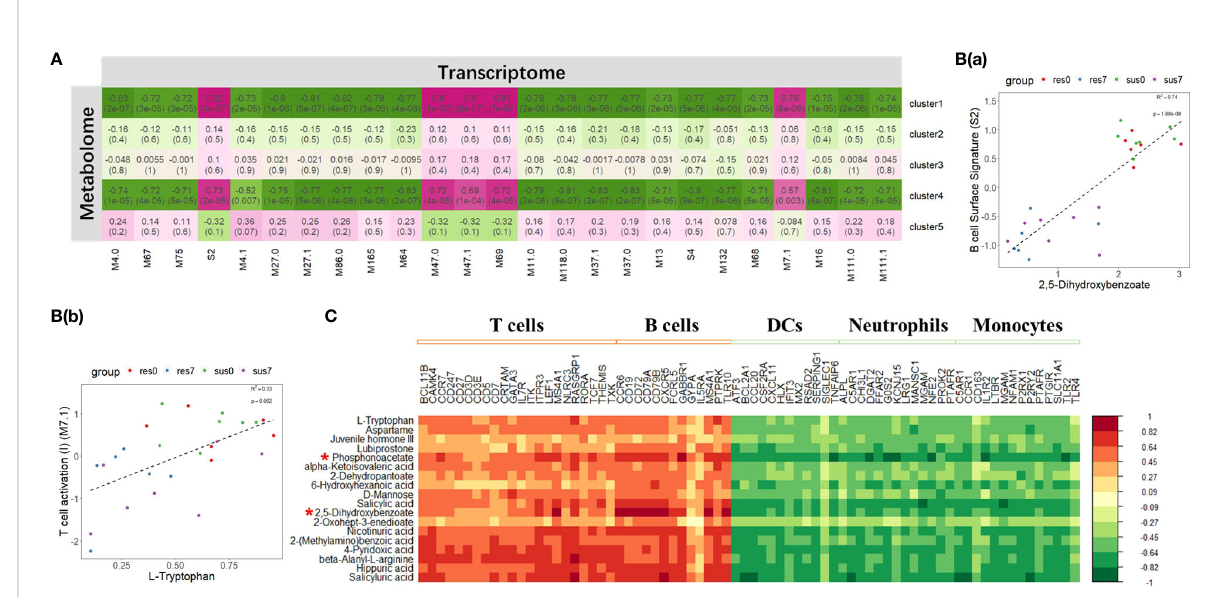
FIGURE 7 (A) Correlation between transcriptomic BTM clusters and metabolomic clusters; The magenta to green scale color indicates a positive to negative Pearson ’ s correlation coef fi cient, and coef fi cient values and the corresponding p-values were labeled on the boxes. (B (a) ) Correlation between B cell surface signature (S2) module and 2,5-dihydroxybenzoate. (B (b) ) Correlation between T cell activation (II) (M7.1) module and L- tryptophan. (C) Correlation between DE metabolites in cluster 1, 4 and marker genes in T cells, B cells, DCs, neutrophils and monocytes related modules; the horizontal axis represents DEGs, and the vertical axis represents DE metabolites. Top 2 signi fi cant metabolites were marked by